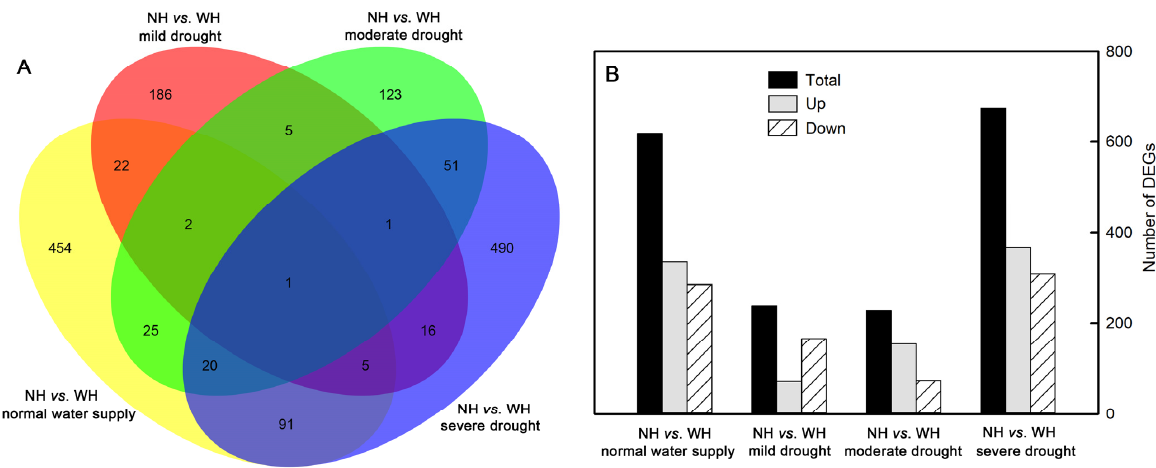
Figure 6. Number of differentially expressed genes (DEGs). Venn diagram showing the number of DEGs ( A ) and uumber of DEGs up-regulated and down-regulated ( B ) between grown without host (NH) and grown with host (WH) under normal water supply, mild drought stress, moderate drought stress, and severe drought stress conditions.